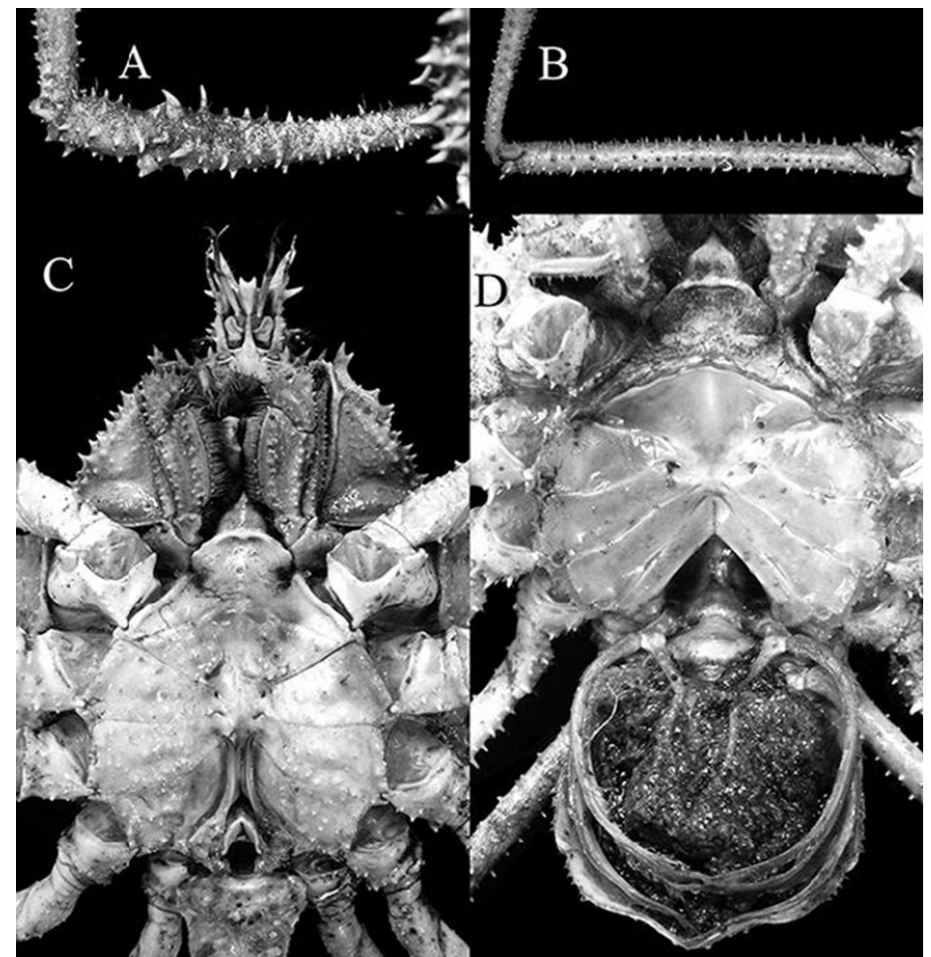
Figure 11. Pleistacantha kannu sp. n. A, B paratype ovigerous female (cl 91.3 mm, cw 75.5 mm) (DABFUK), India C holotype male (cl 106.2 mm, cw 87.0 mm) (CASAU), India D paratype ovigerous female (cl 84.4 mm, cw 71.5 mm) (CASAU),